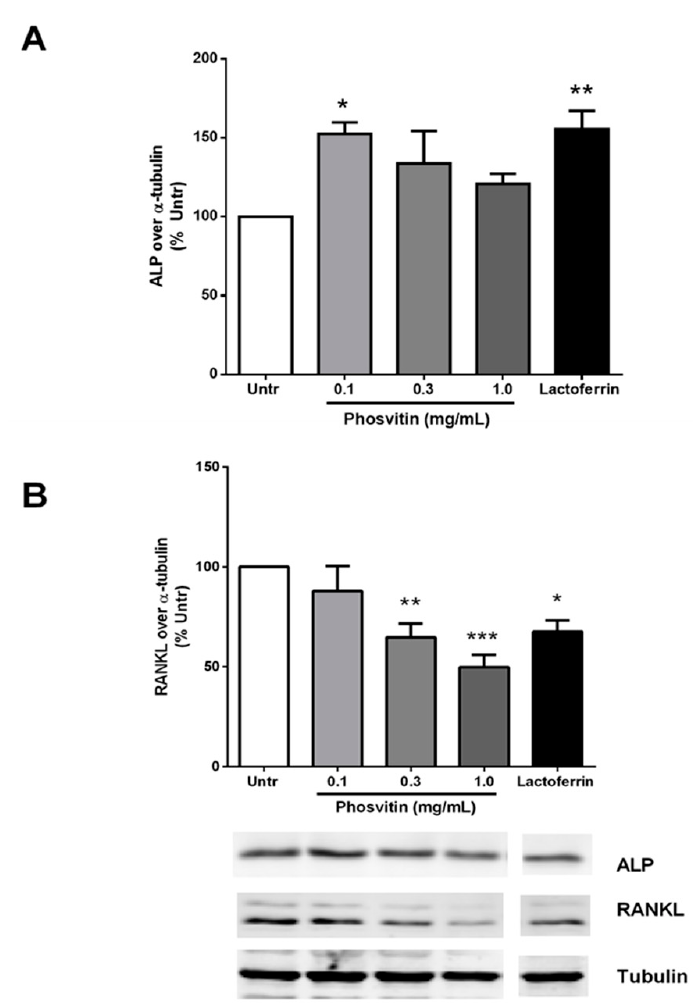
Figure 1. Phosvitin increases alkaline phosphatase (ALP) and decreases receptor activator of nuclear factor kappaB ligand (RANKL) in osteoblastic cells. Confluent monolayers of MC3T3-E1 cells were